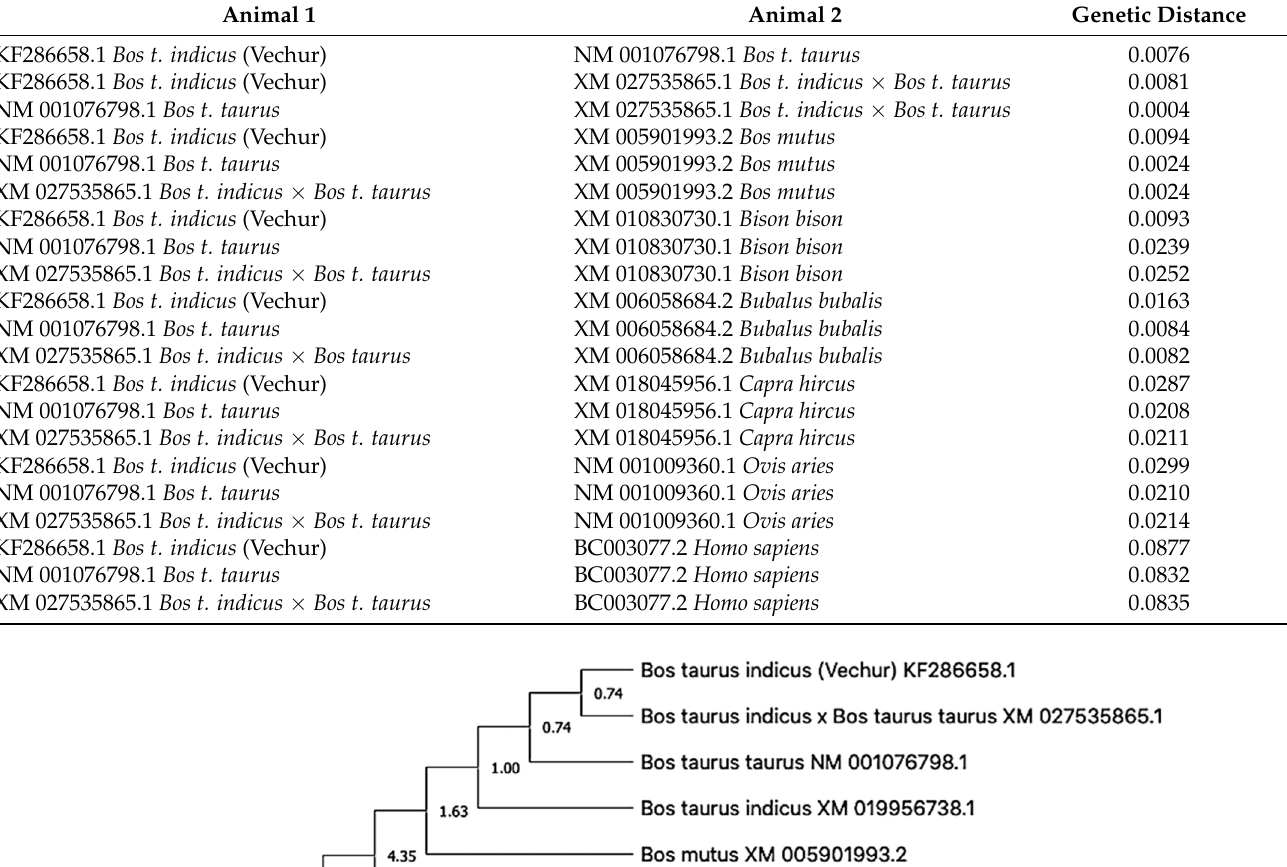
Table 4. Pair-wise genetic distance between different lineages based on the mRNA sequence comparison of the ATP1A1 gene.